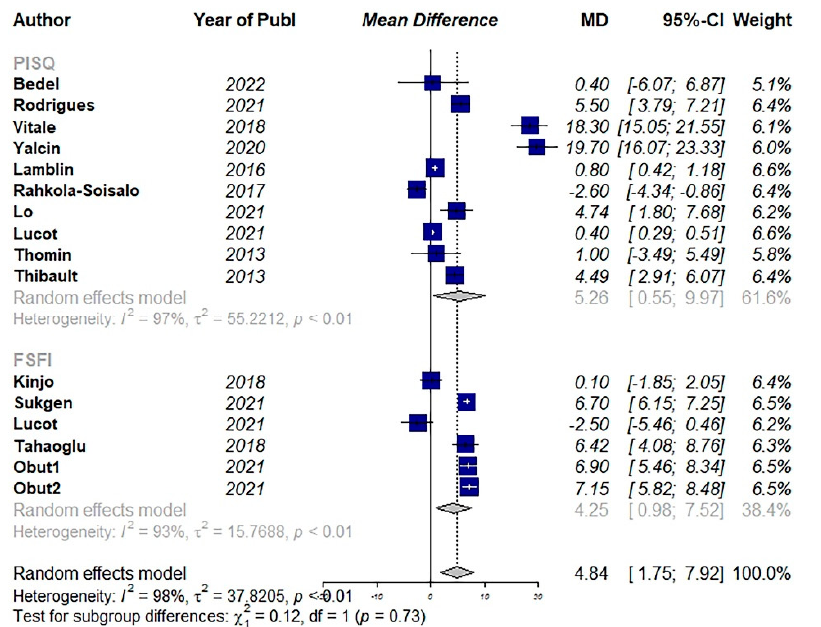
( p = 0.01) indicated a possible source of publication bias (Figure 8).